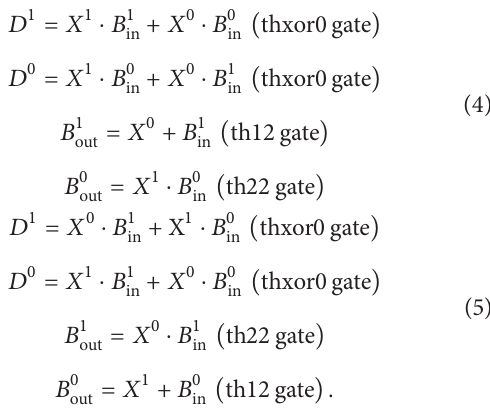
Figure 7. NCL OS and NCL ZS have the subtrahend